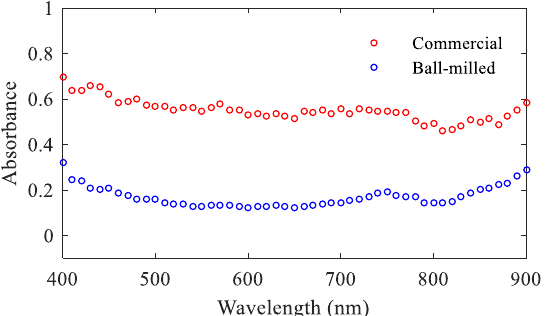
Figure 4. Absorbance spectra for ball-milled (blue) and commercial (red) MgO NPs. The y-axis shows absorbance in normalized units. The dashed line indicates the 532 nm wavelength used to excite the NPs for fluorescence. A concentration of 0.5 mg/mL was used both for the commercial and ball-milled MgO NPs.